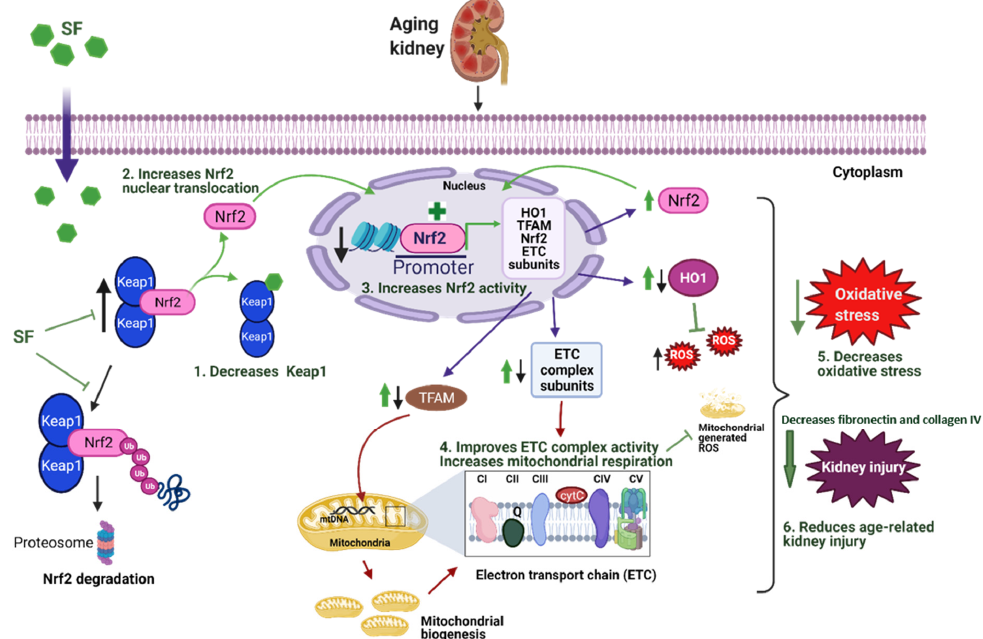
Figure 8. Schematic of NRF2 signaling in the aged kidney and effect of sulforaphane. Black arrows show sequence of pathways in the aging kidney, and green arrows show effect of sulforaphane. NRF2 signaling is impaired in aging kidney due to increased KEAP1, decreased NRF2 nuclear translocation and promoter binding activity. As a result, NRF2 target genes, Ho1 , Tfam , and ETC subunit expression is decreased, leading to compromised mitochondrial respiration, increased oxidative stress, and kidney injury. Sulforaphane increases Nrf2 gene expression, decreases KEAP1 protein, increases NRF2 translocation, and increases NRF2 transcriptional activity, leading to gene expression of Nrf2 and target genes. Increased NRF2 targets, HO1, TFAM, and ETC subunits improves mitochondrial respiration and subsequently ameliorates oxidative stress and reduces kidney injury by decreasing renal injury markers, fibronectin and collagen IV, during aging. SF, sulforaphane; HO1, heme oxyge- nase 1; TFAM, transcription factor A, mitochondrial; ETC, electron transport chain; Ub, ubiquitin; ROS, reactive oxygen species. Created with